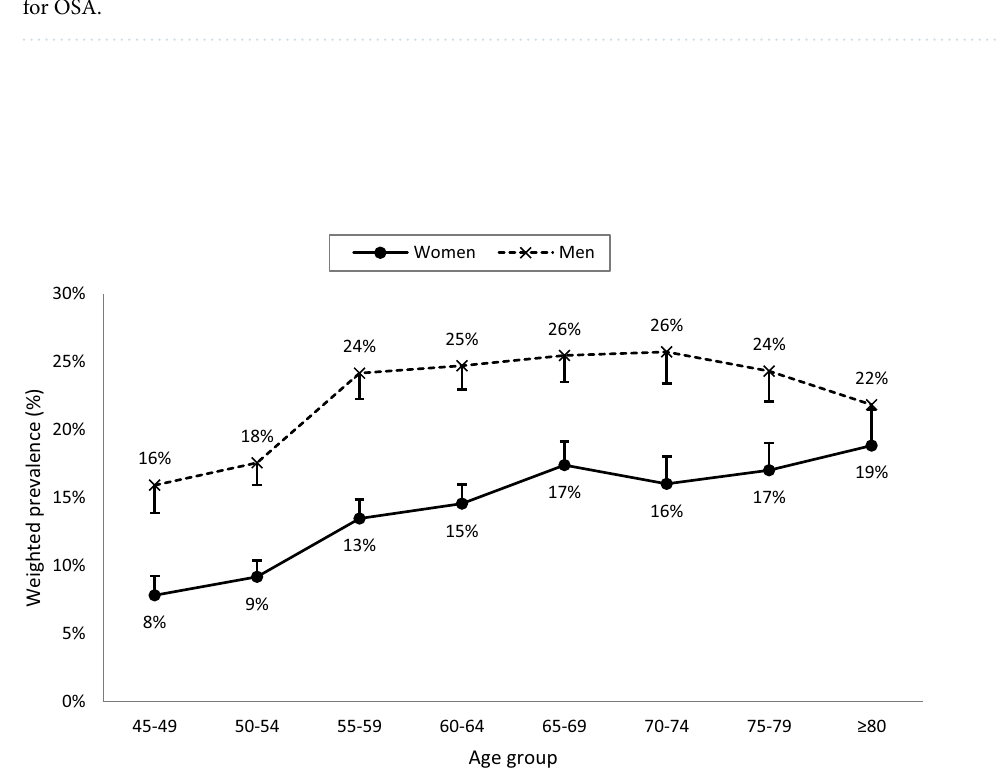
Table 2. Prevalence (95% CI) of individual STOP-Obesity variables in women and men at low- and high-risk for OSA.